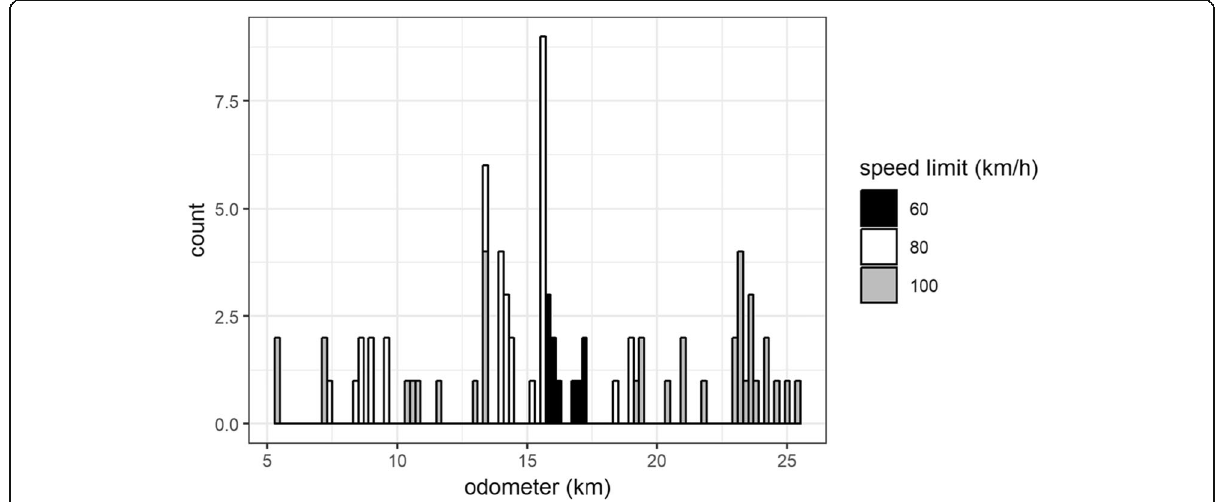
Fig. 6 The number of speed warnings along the road in 200 m bins. Odometer reading along the road (km) on the